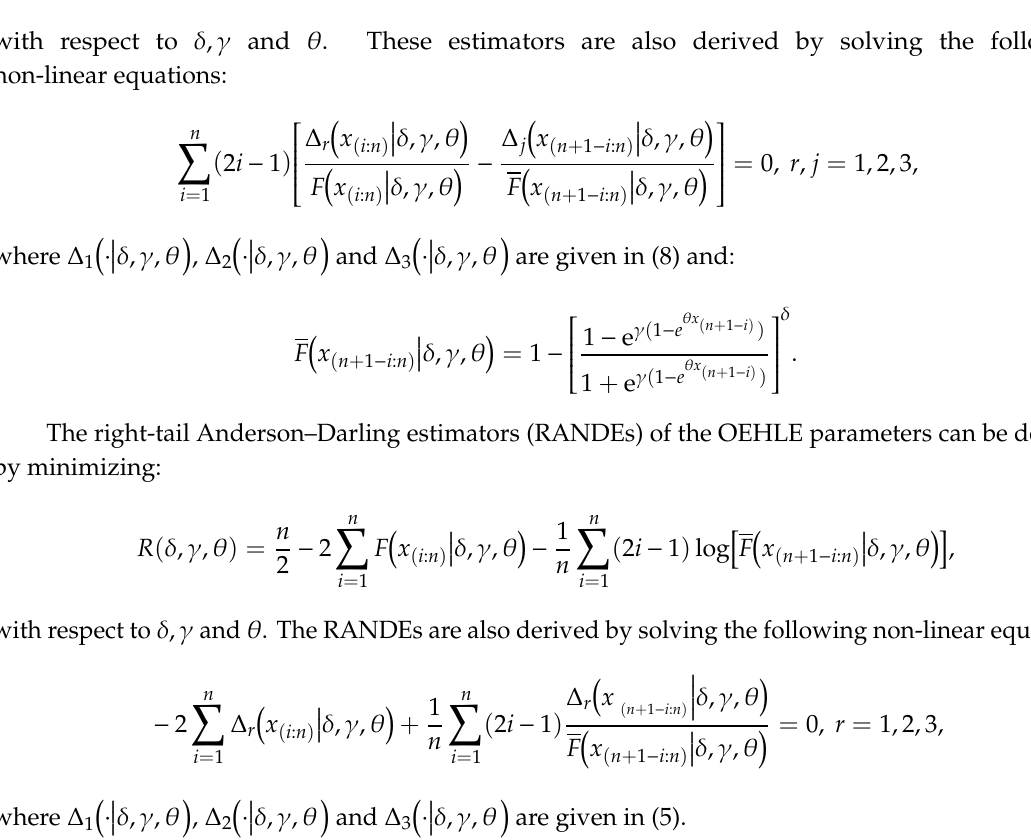
Table 1. Partial and overall ranks of di ff erent estimation methods for all combinations of ( δ , γ , θ ) T . ( δ , γ , θ ) T n MLEs MPSEs LSEs CVMEs WLSEs PCEs ANDEs RANDEs